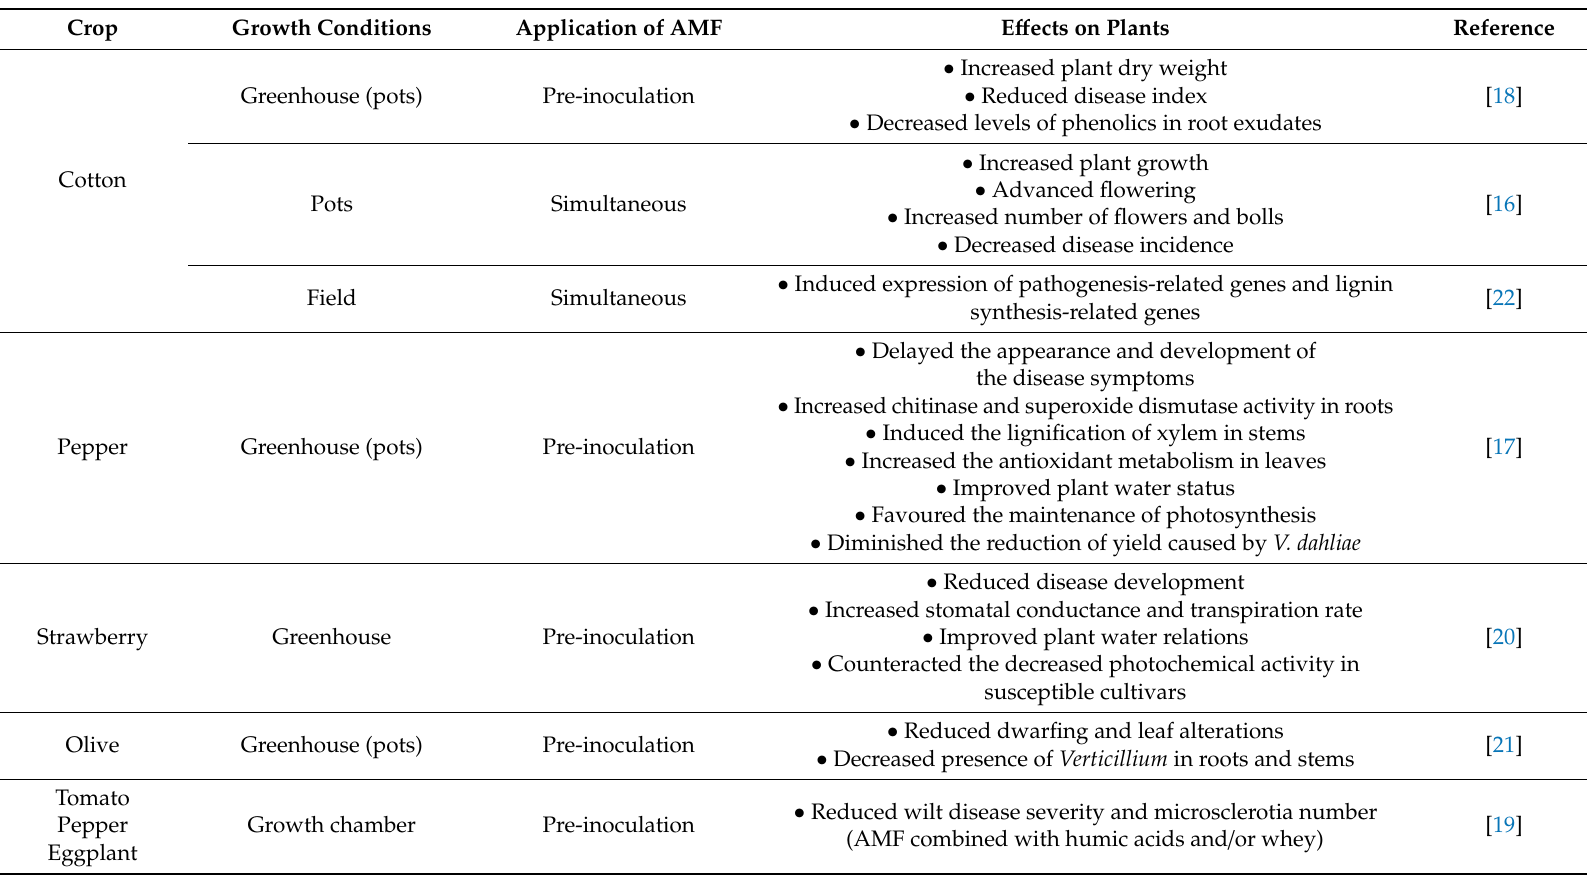
Table 1. Compendium of studies dealing with the e ff ect of arbuscular mycorrhizal fungi (AMF) as bioprotectors of crops against Verticillium